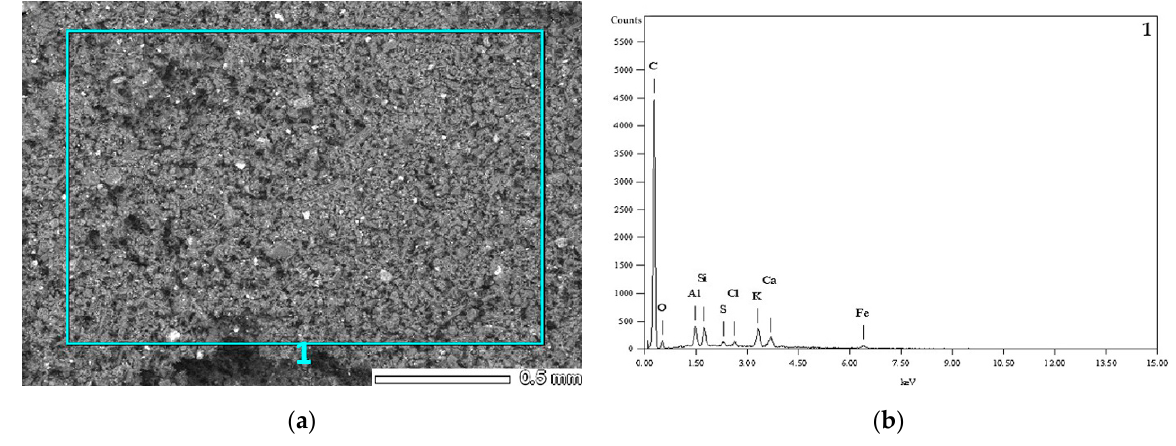
Figure 4. Dispersion energy spectrum of X-rays (EDS) for certain area (1) of activated carbon, ( a ) photo of analyzed sample of activated carbon; ( b ) spectrum.